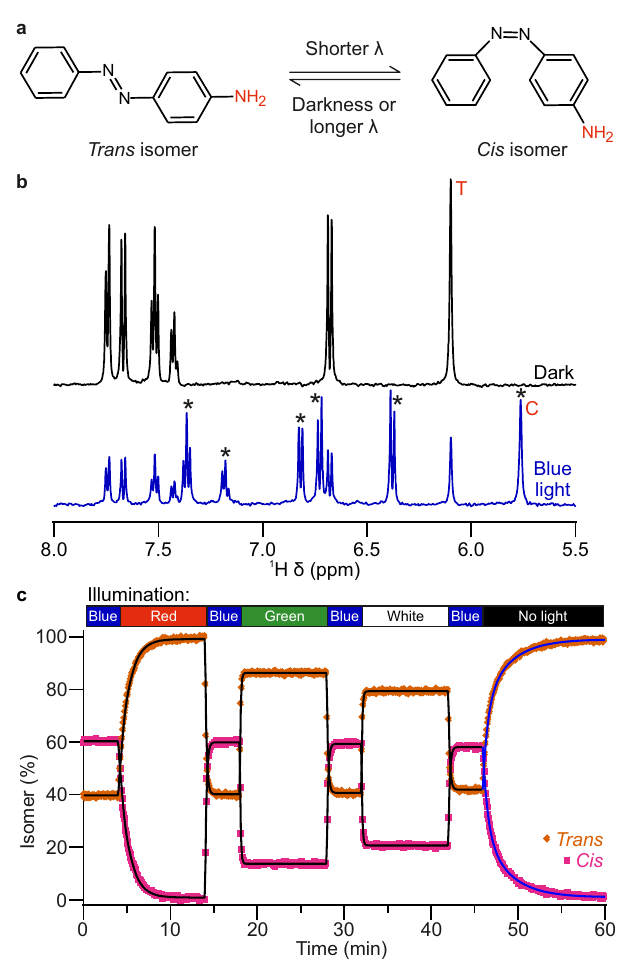
Fig. 6 Photoisomerisation of 4-aminoazobenzene (AAB) studied using NMRtorch setup. a Schematic of trans – cis isomerisation of AAB, with amine groups used for NMR isomer assessments highlighted (red). b Example 1 H NMR spectra at equilibrium under darkness (top) and blue light (bottom). Under darkness all signals arise from trans isomer, while asterisks denote up fi eld signals arising from cis isomer appearing under blue light. Intensity of equivalent amine NMR signals marked with T ( trans isomer, ~6.10 ppm) and C ( cis isomer, ~5.76 ppm) used to determine isomer percentage. c Kinetics of AAB photoisomerisation studied by photo-NMR spectroscopy, with sample pre-equilibrated with blue light for 5 min before recording, and different colours toggled as indicated. The experimental data was fi tted to mono- (black lines) and bi-exponential (blue lines) equations to extract kinetic parameters for individual